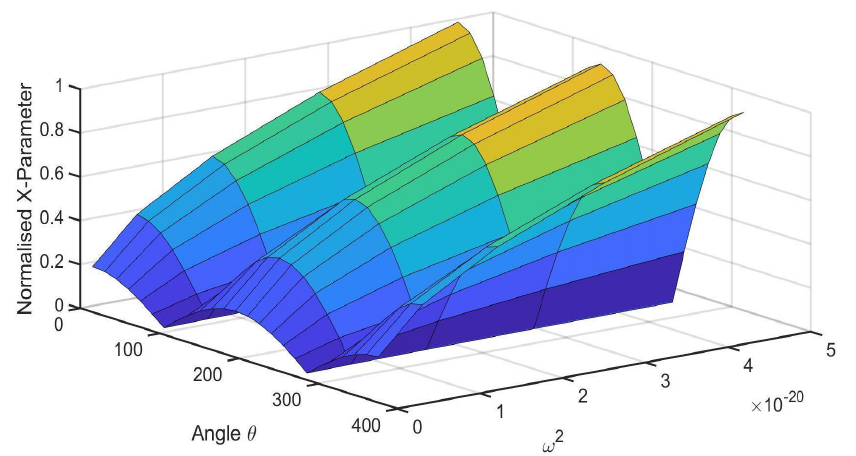
(cid:0) (cid:1) X p as a function of the separation constant